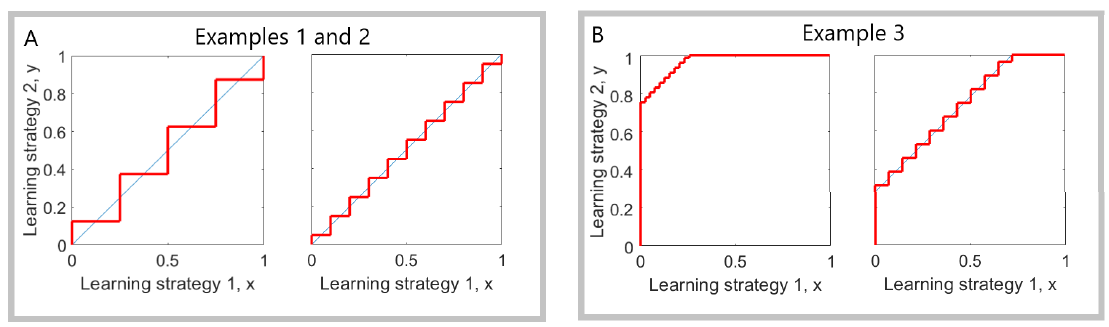
Figure 2. Optimal learning paths for examples in the manuscript. ( A ) Examples 1 and 2: optimal learning paths for R 1 and R 2 follow the line x = y (blue line). We plot the solution (red stepwise line) for: (1) n = 5, (2) n = 10. ( B ) Example 3: an optimal learning path for R 3 where n = 12 and: (1) a = 5, (2) a =